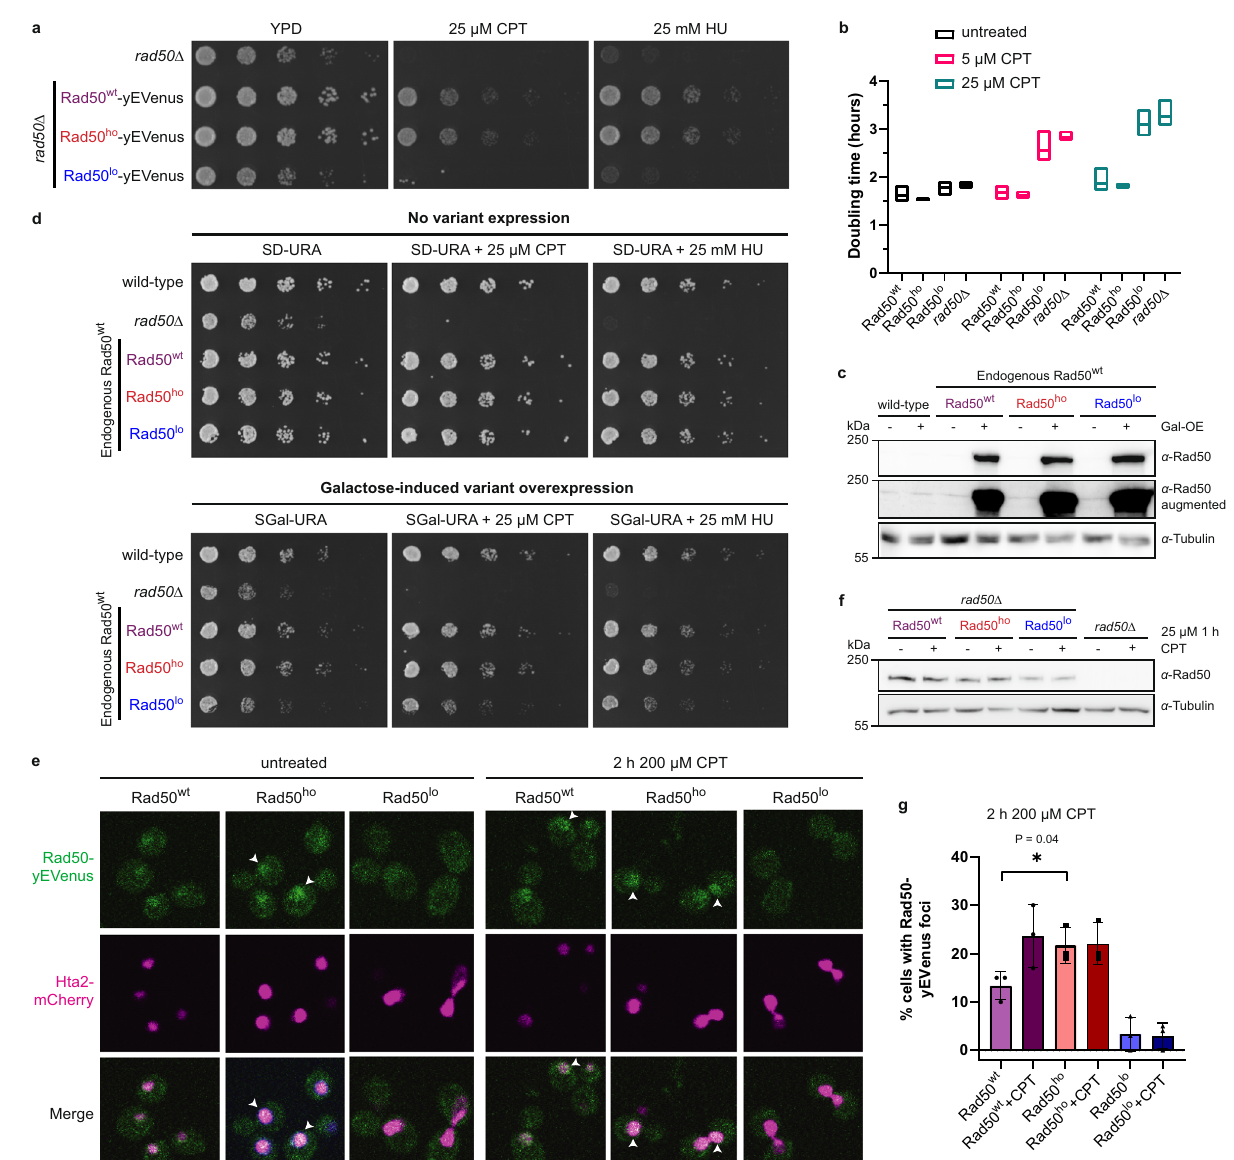
Fig. 5 Foci formation and DNA repair require MRX oligomerization in vivo. a Serial dilution of exponentially growing S. cerevisiae rad50 4 cells expressing Rad50 wt/ho/lo -yEVenus, spotted on agar plates (YPD) + / − DNA damage-inducing camptothecin (CPT) or hydroxyurea (HU), and incubated for 2 days at 30 °C. n = 3. b Doubling times of exponentially growing rad50 4 cells and rad50 4 strains expressing Rad50 wt/ho/lo -yEVenus + / − CPT treatment. Mean and minimum to maximum values shown, n = 3 independent experiments. c Anti-Rad50 western blot showing galactose-induced overexpression of untagged Rad50 wt/ho/lo in wild-type cells ( + Gal-OE). Center panel is contrast-enhanced to show endogenous Rad50 wt levels (wild-type, − Gal-OE). α - Tubulin controls equal loading. n = 3. d Serial dilution of exponentially growing wild-type cells expressing galactose-inducible Rad50 wt/ho/lo , spotted on SD-URA agar plates with glucose ( − ) or galactose ( + variant overexpression), and incubated at 30 °C for 2 days. Before overexpression, cells carrying Rad50 wt/ho/lo were similarly resistant to DNA damage as wild-type cells due to endogenous Rad50 wt ( − , top). n = 3. e Representative live-cell images of untreated or CPT-treated rad50 4 cells expressing Rad50 wt/ho/lo -yEVenus with histone Hta2-mCherry as nuclear marker. Arrows indicate nuclear Rad50 foci (Supplementary Fig. 7a). f Anti-Rad50 western blot showing expression levels of Rad50 wt/ho/lo -yEVenus in rad50 4 cells before ( − ) and after ( + ) CPT treatment. α -Tubulin controls equal loading. n = 3. g Quanti fi cation of live-cell imaging in e . The percentage of cells with nuclear Rad50-yEVenus foci (arrows in e ) is shown for untreated and CPT-treated rad50 4 cells expressing Rad50 wt/ho/lo -yEVenus. Mean± SD, n = 3 independent experiments, unpaired two-tailed t -test. Scale bars: 5 µ